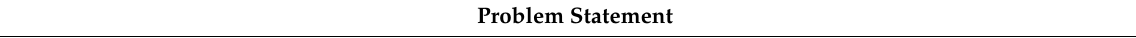
Table 2. Definition of the secondary distribution problem.